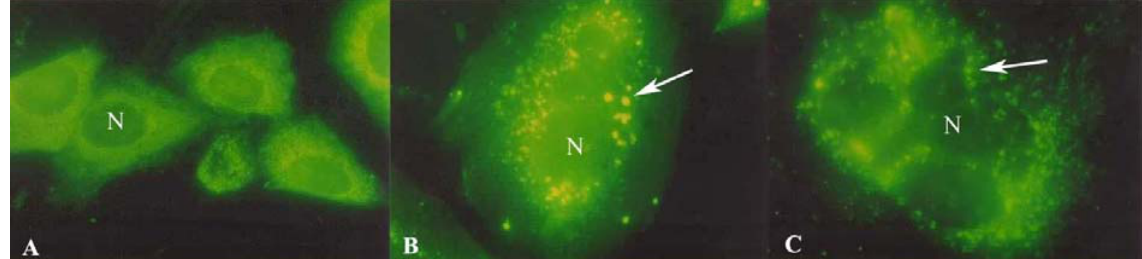
Figure 2: Visualization of endoplasmic reticulum of CHO-K1 cells after C. d. terrificus crude venom treatment. (A) Control cells. (B) Cells treated with 10 μ g/ml of venom for 24 hours. Fluorescent dots can be seen around the nucleus, probably due to venom collection (arrow). (C) Cells treated with 100 μ g/ml of venom for 24 hours. Presence of vesicles and venom collection (arrow). N= nucleus. X